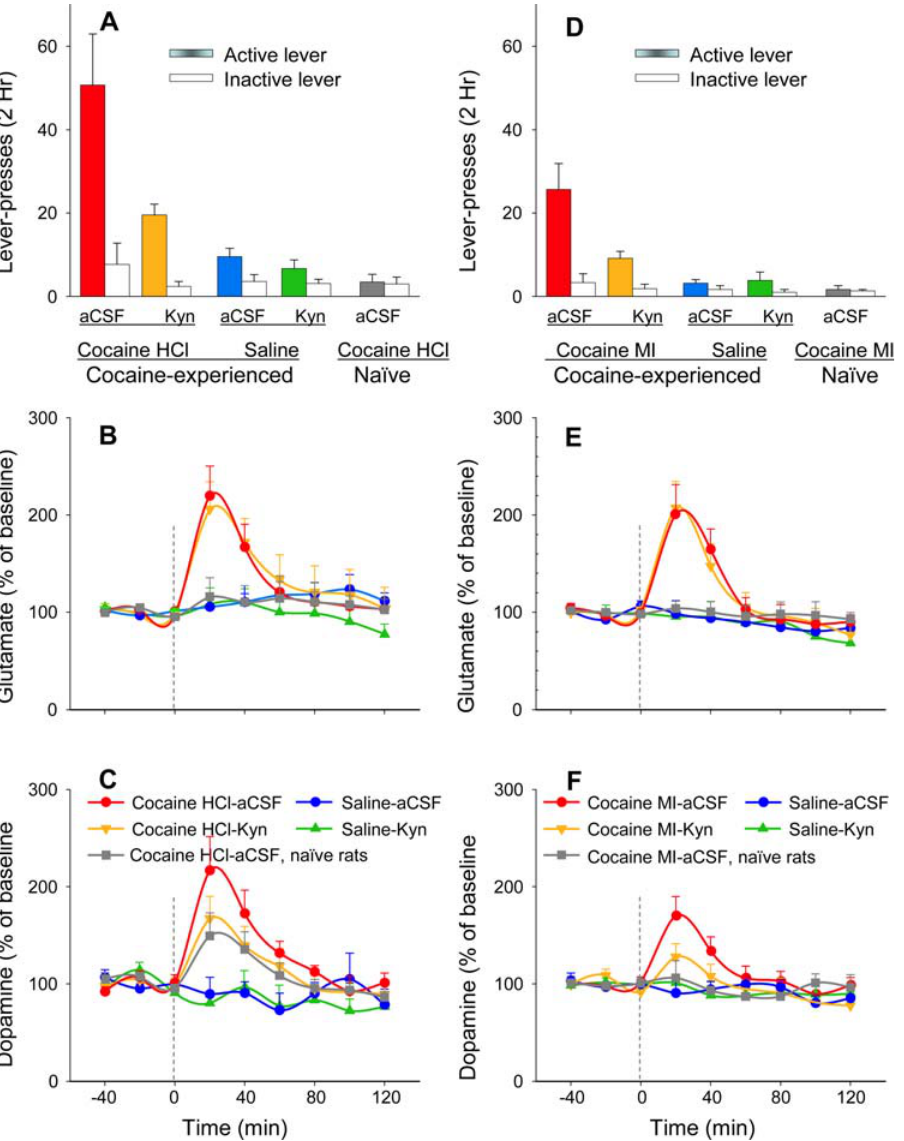
Figure 1. Mean lever-pressing (top panels) and ventral tegmental glutamate (middle panels) and dopamine (lower panels) fluctuations during reinstatement of lever-pressing by cocaine HCl (left panels) and cocaine MI (right panels). IP injections of cocaine HCl (10 mg/kg) or cocaine MI (13 mg/kg) were given at Time=0. Abbreviations: aCSC (artificial cerebrospinal fluid), Kyn (kynurenic acid, glutamate antagonist), cocaine HCl (cocaine hydrochloride), cocaine MI (cocaine methiodide). The notation ‘‘Cocaine HCl-aCSF’’ indicates the condition where the IP injection was cocaine HCl and where the dialysate included aCSF.